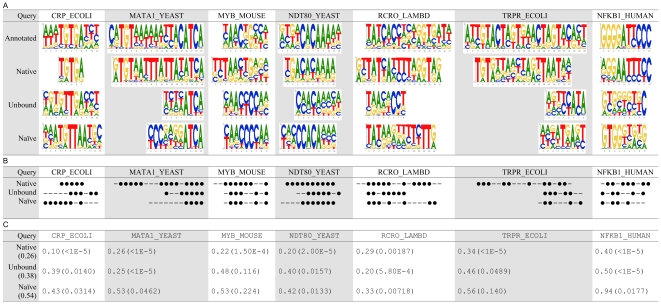
Predictions by the proposed method on the seven test cases.The predictions of the proposed method are denoted as ‘Unbound’, in comparison with the annotated PWMs (‘Annotated’), the predicted PWMs based on native complexes (‘Native’) and the complexes of homologues (‘Naïve’). (A) PWMs. (B) A position is marked as ‘•’ if its most favorable base type was correctly predicted, or marked as ‘–’ otherwise. (C) Ψ-scores and the corresponding p-values. The value within the parentheses of the first column indicates the average Ψ-score.